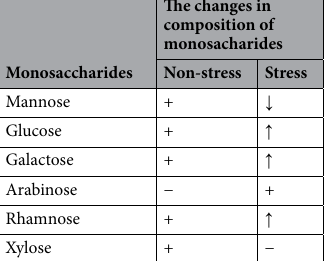
Table 1. Summary of the changes in the monosacharide composition of EPS produced by L. plantarum VAL6 under pH and sodium chloride stresses. (−) Not detected; (+) Detected; ( ↓ ) Decreased; ( ↑ ) Increased.